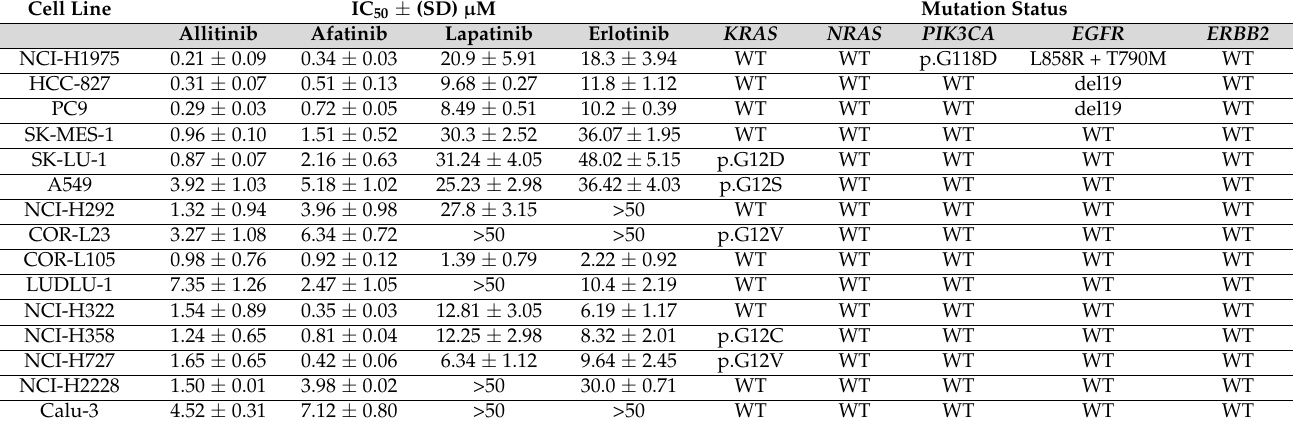
Table 1. Mutation analysis and anti-EGFR drug response of NSCLC cell